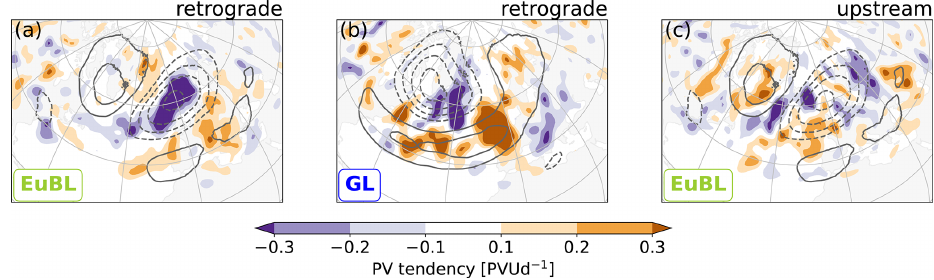
Figure 11. Same as Fig. 10, but for the convergence of the eddy PV flux for the retrograde cluster for EuBL (a) and GL (b) and the upstream cluster for EuBL (c) . Note the different color bar.